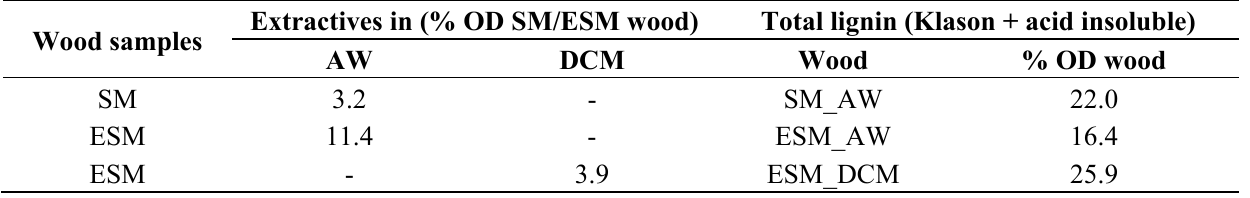
Table 1. Extractives and total lignin content of sugar maple (SM) and extracted sugar maple (ESM) based on oven-dried (OD) wood [5]. Reproduced with permission from [5]. Copyright 2012, Taylor and